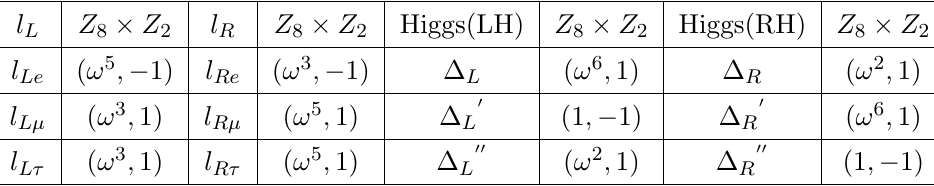
Table 5 . Particle assignments for